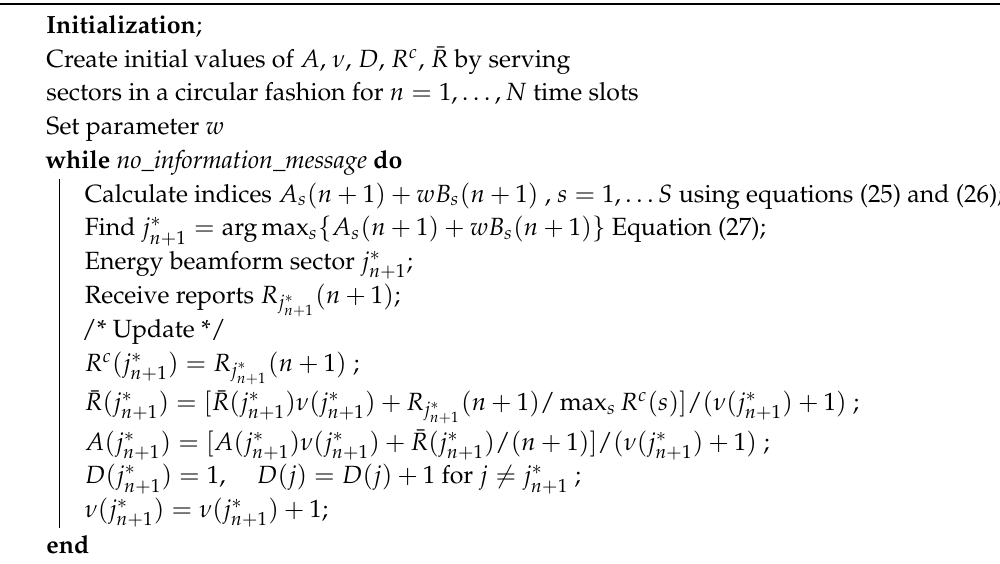
Algorithm 1: Dynamic Sector Energy